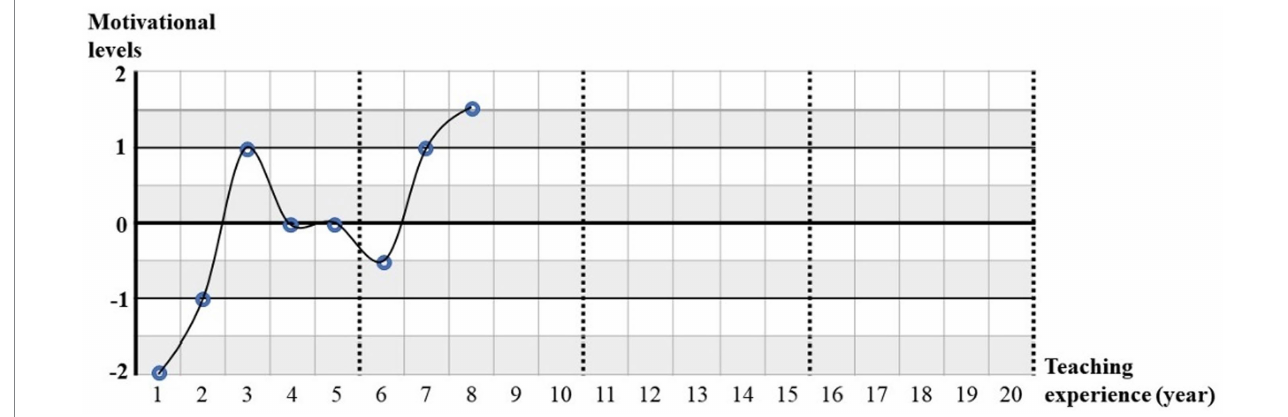
FIGURE. 1 Sample of motivational change graph for academic research. Motivation level 2 = very interesting, 1 = interesting, 0 = neither interesting nor boring, − 1 = not interesting, − 2 = very